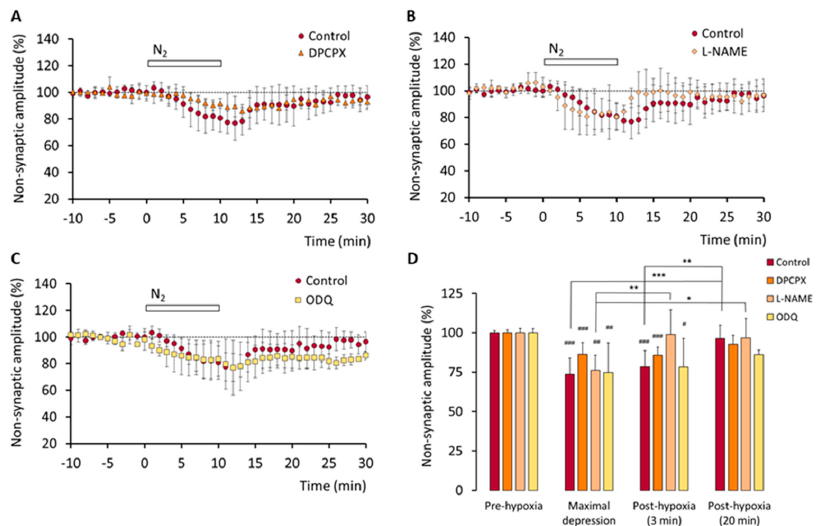
Figure 2. Adenosine A 1 receptors and NO/cGMP are not involved in hypoxia-induced depression of the non-synaptic component of the fEPSPs. Time course of hypoxia effect on the amplitude of the non-synaptic peak in control conditions ( n = 5) and after pre-treatment with: ( A ) the A 1 receptors antagonist DPCPX (50 nM; n = 3); ( B ) the NO synthase inhibitor L-NAME (2 mM; n = 5); ( C ) the NO-sensitive GC inhibitor ODQ (100 µM; n = 4). ( D ) Comparison of the mean amplitude (± SD) of the non-synaptic peak recorded during the 10 min before hypoxia onset (pre-hypoxia), during the minute corresponding to the maximal hypoxia-induced depressive effect, and during min 3 and min 20 after re-oxygenation onset in the different conditions indicated. ### p < 0.001, ## p < 0.01, # p < 0.05 (vs. pre-hypoxia). *** p < 0.001, ** p < 0.01, * p < 0.05 (vs. the columns indicated). By contrast, the peak amplitude of the synaptic component of the fEPSPs was much less depressed by hypoxia in slices pre-treated with DPCPX ( n = 4) than in control slices: